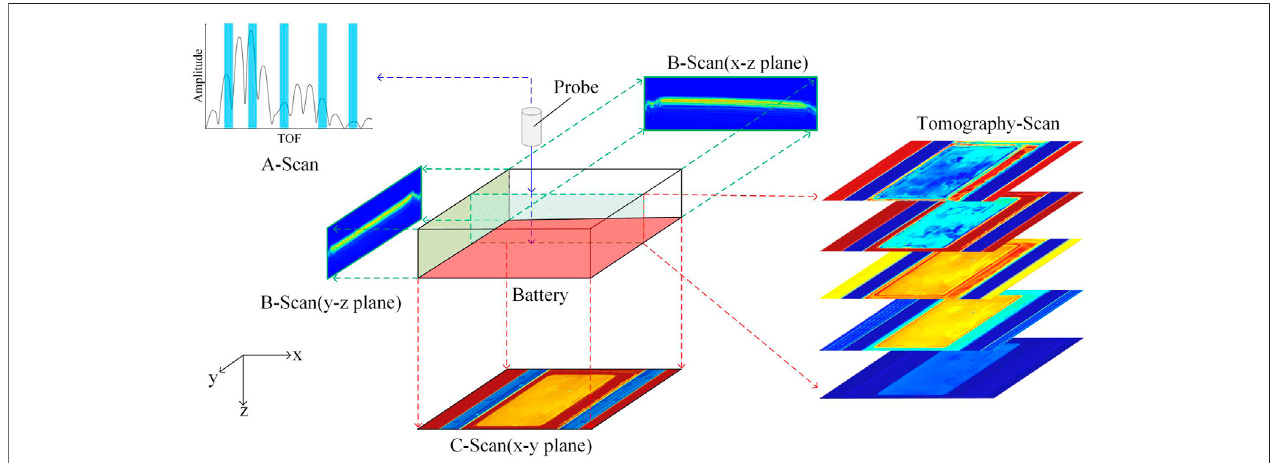
FIGURE 3 | Schematic diagrams of different types of acoustic imaging.